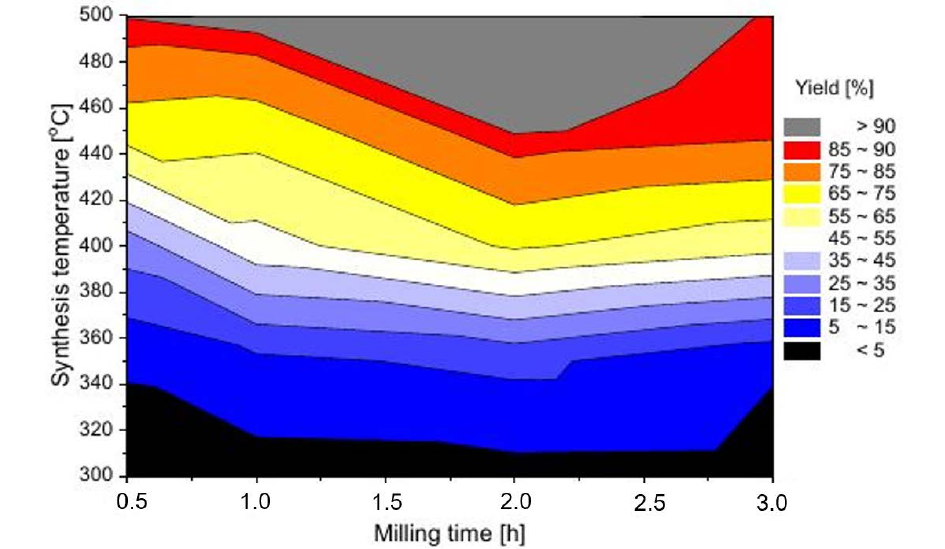
Figure 6. Mg 2 FeH 6 synthesis efficiency